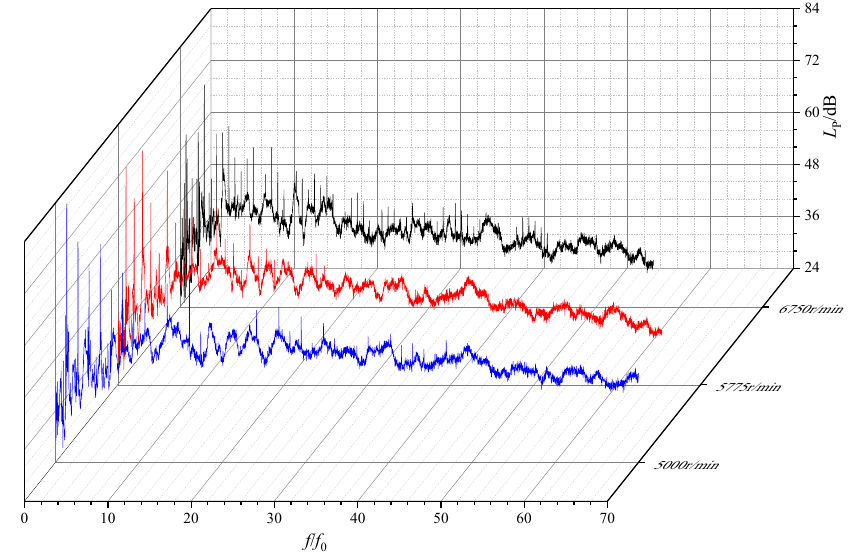
Figure 11. Contrast chart of frequency spectrum under the full opening of the valve.